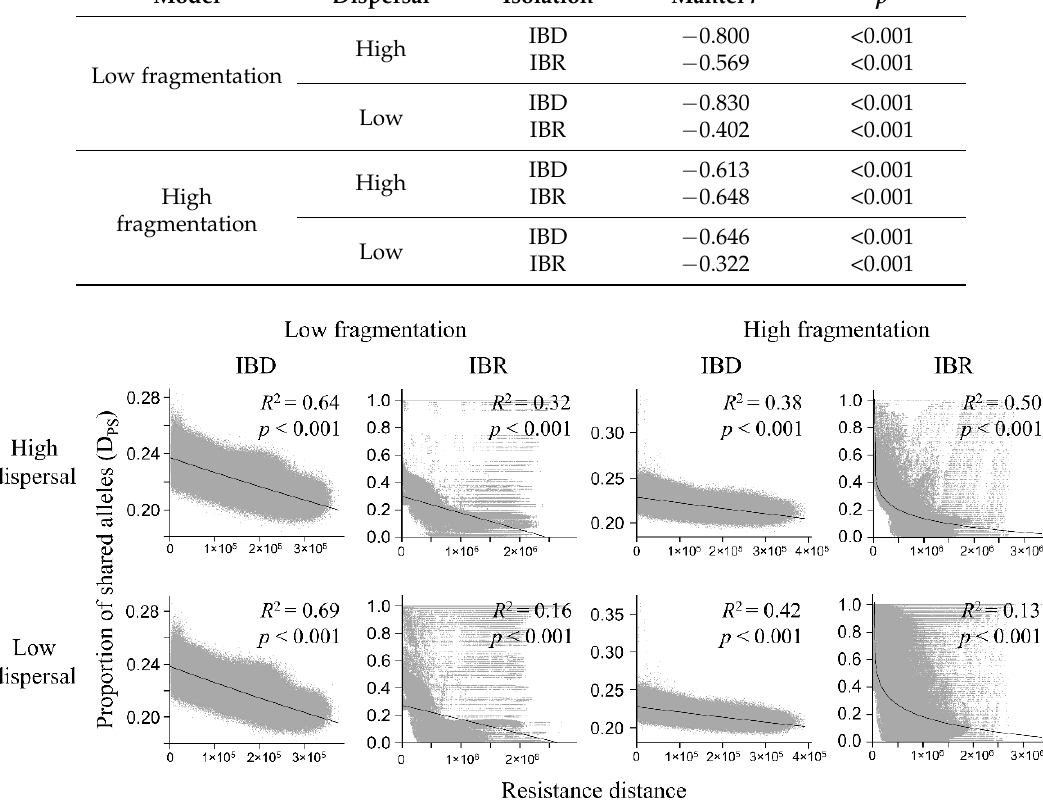
Figure 6. Relationship between pairwise D ps and resistance distance in the low-fragmentation model (left two columns) and the high-fragmentation model (right two columns). Top row: high-dispersal scenario (300 km). Bottom row: low-dispersal scenario (200 km). Proportion of shared alleles (y-axis) is calculated with ecodist R package. Resistance distance (x-axis) is the least-cost path resistance between nodes. Gray markers represent each pairwise node distance. Adjusted R 2 and p -value are shown.